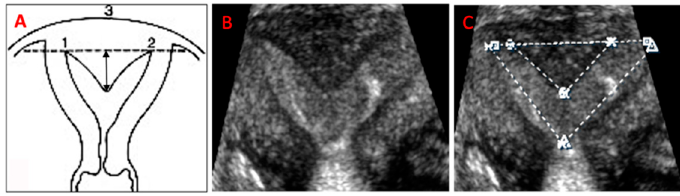
Figure 1. ( A ). Graphic representation and 3-D ultrasound measurement technique of uterine subseptations (1,2 = left and right tubal ostia; 3 = fundal outer contour; arrows: measurement of subseptation length). ( B ). 3-D ultrasound coronal view rendering of a subseptation. ( C ). Measurement of the cavity width ( 1 – 2 ), and subseptation width, for calculation of cavity area on the 3-D ultrasound coronal view.